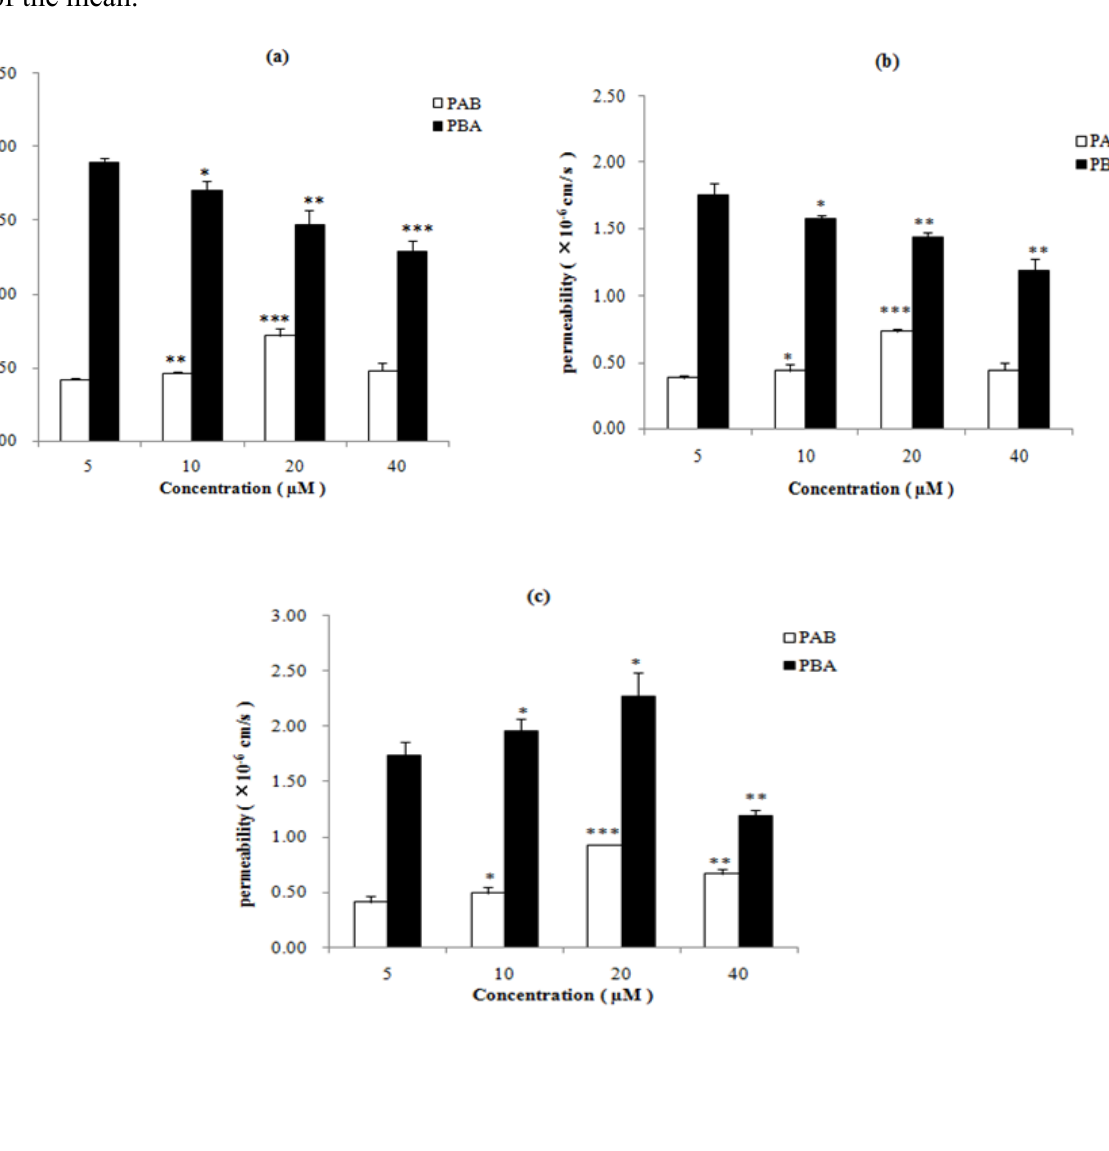
Figure 2. Permeability of epimedins A, B, and C at different concentrations ( a ) epimedin A, ( b ) epimedin B; and ( c ) epimedin C. In the each column figure, white column refers to the absorptive permeability (P ); black column refers to secretory permeability (P ). The AB BA asterisk symbol indicates a statistically significant difference between permeability at 5 μ M (control) and that at a higher concentration. The number of asterisk symbol indicates the level of significance with *** p < 0.001, ** p < 0.01, * p < 0.05. Each data point is the average of three determinations, and the error bars represent the standard deviation of the